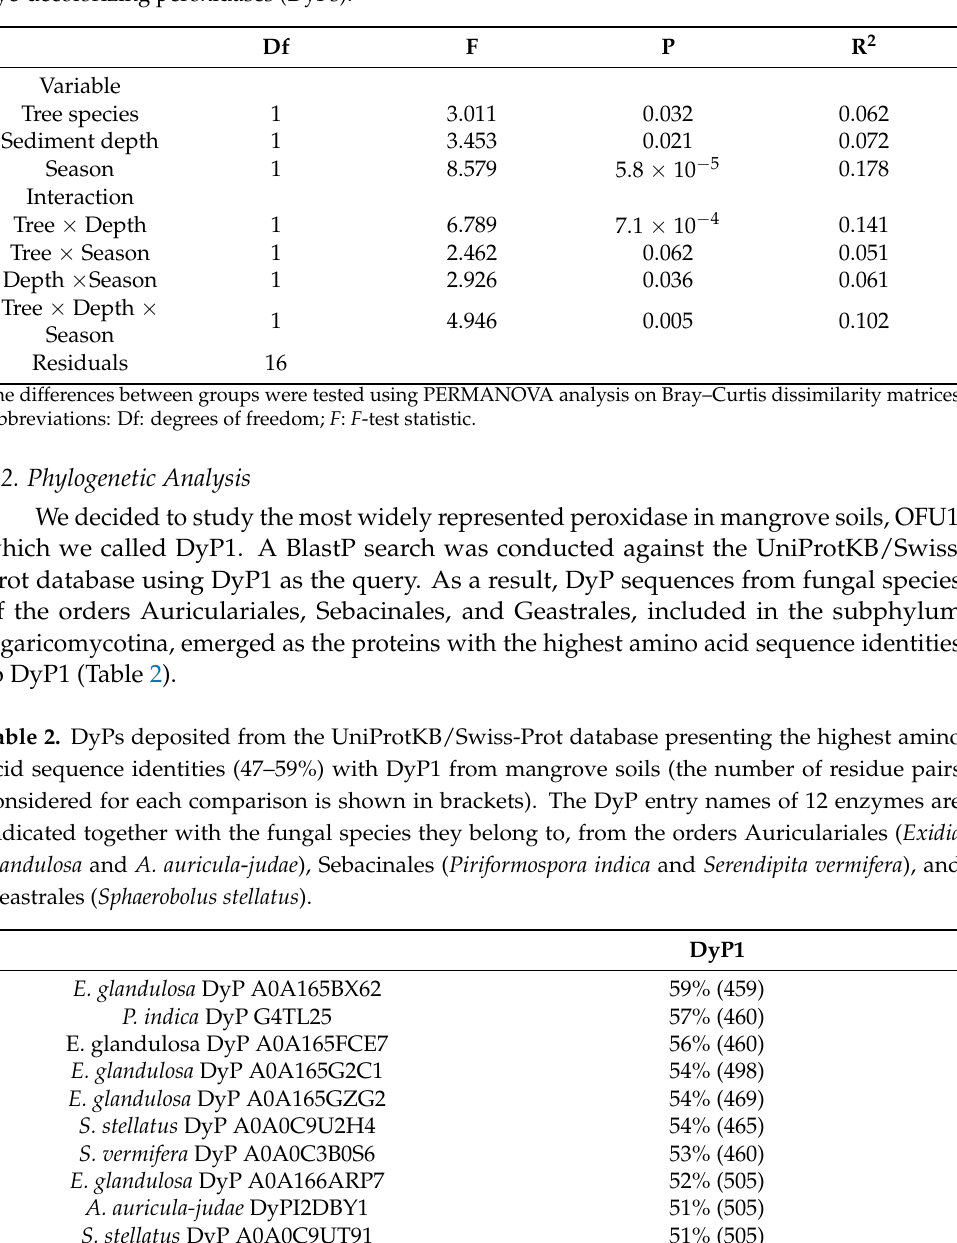
Table 1. Effect of environmental factors on the composition of expressed fungal genes encoding dye-decolorizing peroxidases (DyPs).